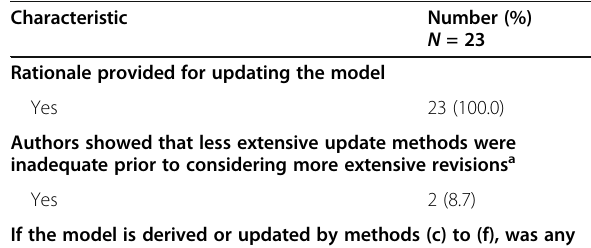
Table 4 Reporting of essential items relevant to validation